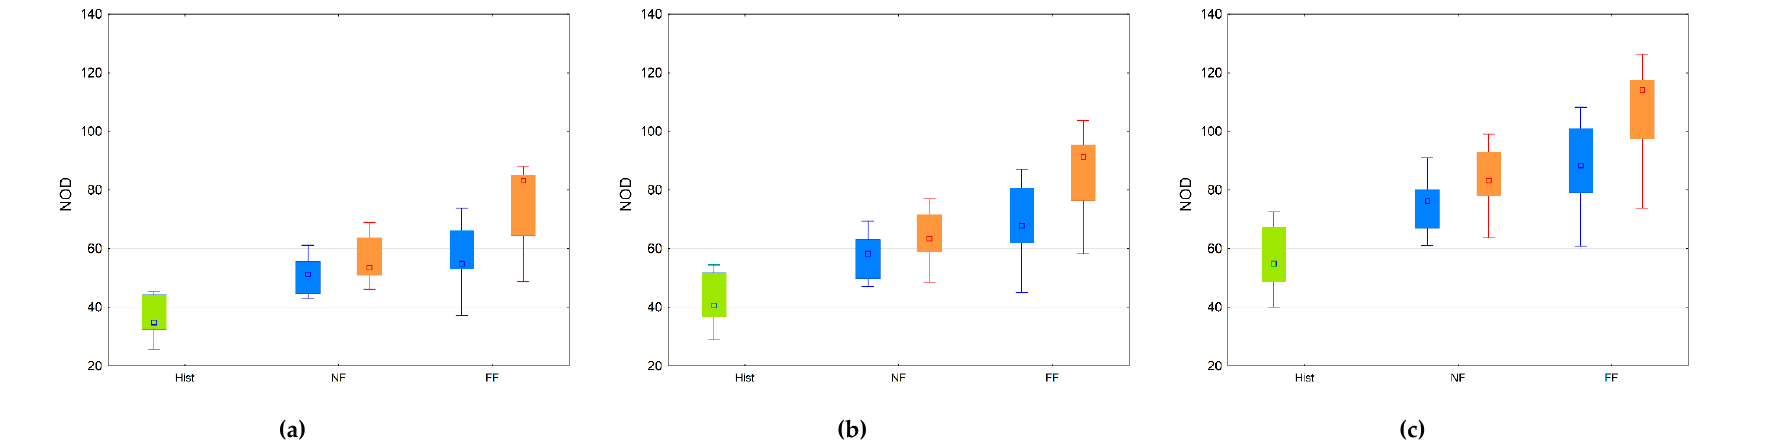
Figure 4. Projected changes in yearly number of days when streamflow exceeds bankfull flow (NOD) for habitat: ( a ) 6430—hydrophilous, tall-herb fringe communities of plains and of the montane to alpine levels, ( b ) 91E0—alluvial forests with Alnus glutinosa and Fraxinus excelsior (Alno-Padion, Alnion incanae , Salicion albae ); ( c ) 91F0—riparian mixed forests of Quercus robur , Ulmus laevis , and Ulmus minor , Fraxinus excelsior , or Fraxinus angustifolia , along the large rivers ( Ulmenion minoris ) in RCP 4.5 (blue) and 8.5 (orange), and the baseline scenario (green).